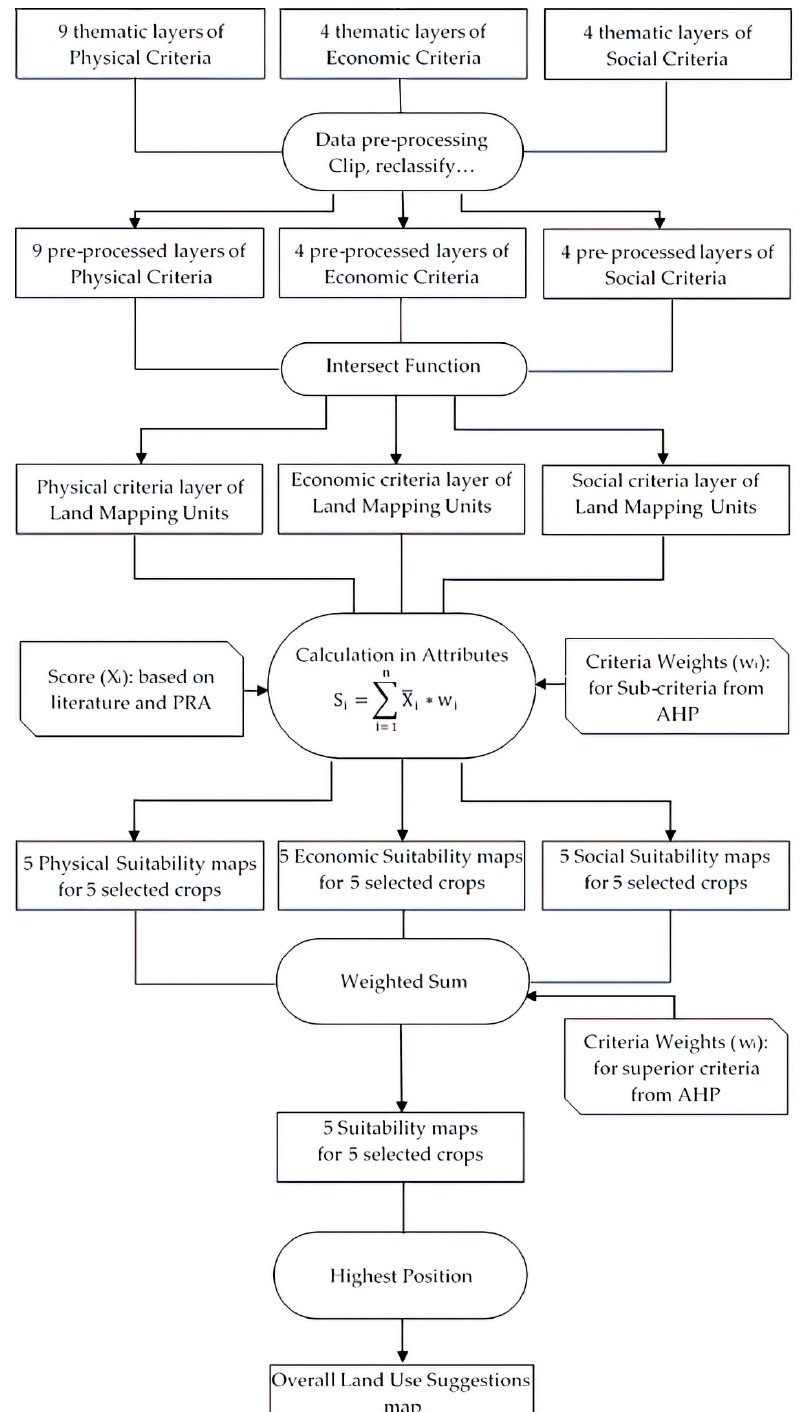
Figure 3. Flow chart of GIS–based land evaluation